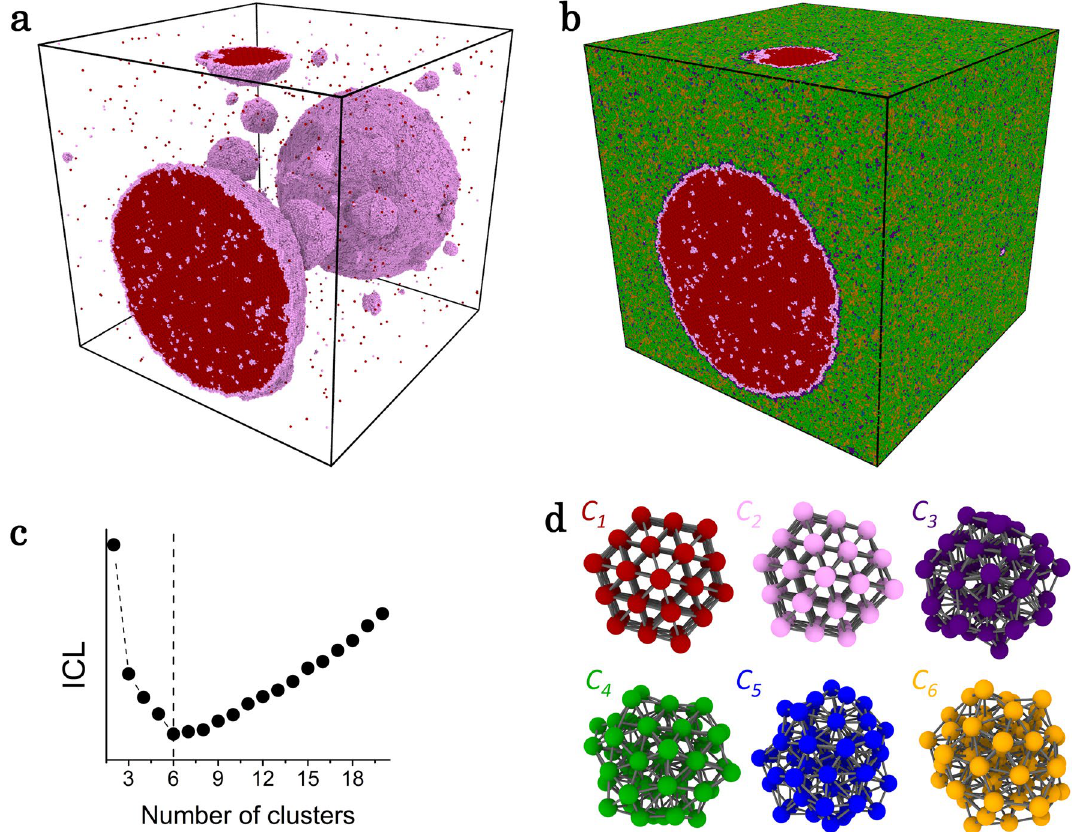
Figure 1. Unsupervised learning of homogeneous nucleation. Snapshot of a 10-million atom MD simulation of Ta during nucleation along the T = 1900 K isotherm ( a , b ). Independent local atomic structures within a cut- off-radius of 6.8 Å form a train set represented in the descriptor space by 215 PH components up to dimension 2. ( c ) Evolution of the ICL criterion as a function of the number of clusters is used to get autonomously the optimal number of clusters shown in ( d ). In ( a ) the snapshot is represented only with atoms in cluster C 1 and cluster C 2 revealing all nuclei (see text), while in ( b ) atoms of all clusters are displayed showing that those in cluster C 3 are located mainly at the border of the nuclei and C 4 , C 5 and C 6 correspond to the surrounding liquid with various topological